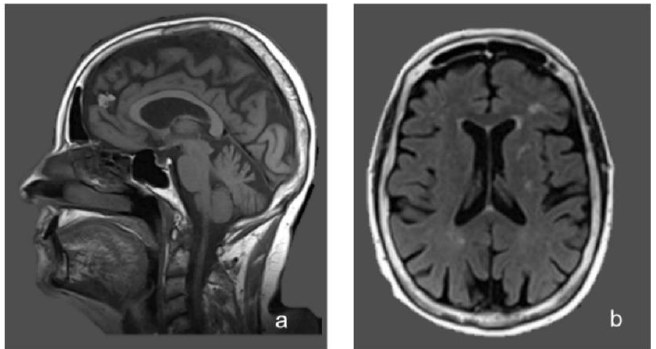
Figure 1. Sagittal ( a ) and axial ( b ) magnetic resonance imaging (MRI) Fluid-Attenuated Inversion Recovery (FLAIR) images of the patient, showing multiple areas of white matter hyperintensity and cerebellar atrophy.